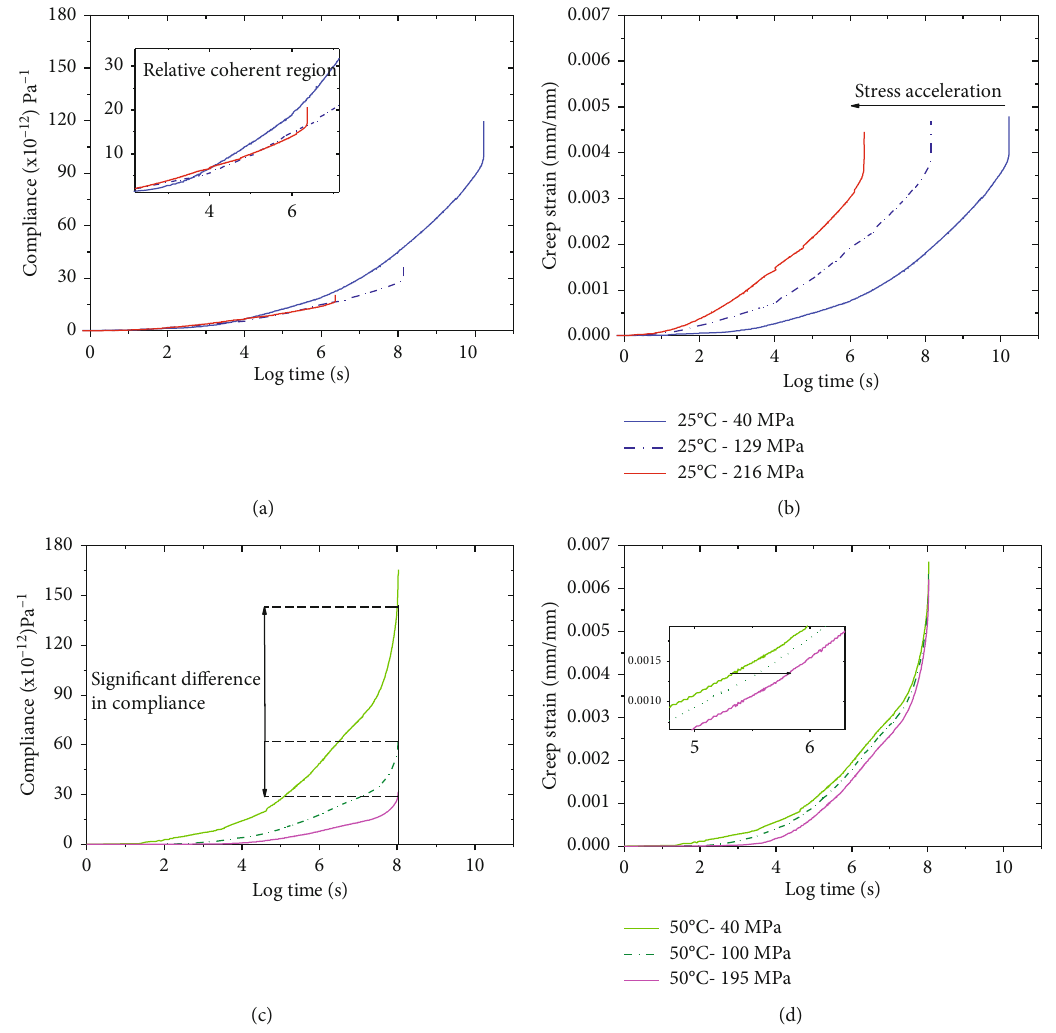
Figure 4: (a) Creep compliance and (b) creep strain master curves at 25 ° C and stress levels of 40, 129, and 216MPa and (c) creep compliance and (d) creep strain master curves at 50 ° C and stress levels of 40, 100, and 195MPa for the MD composite. Table 4: The result of the master curve at di ff erent stress levels for the MD specimens at 25 °